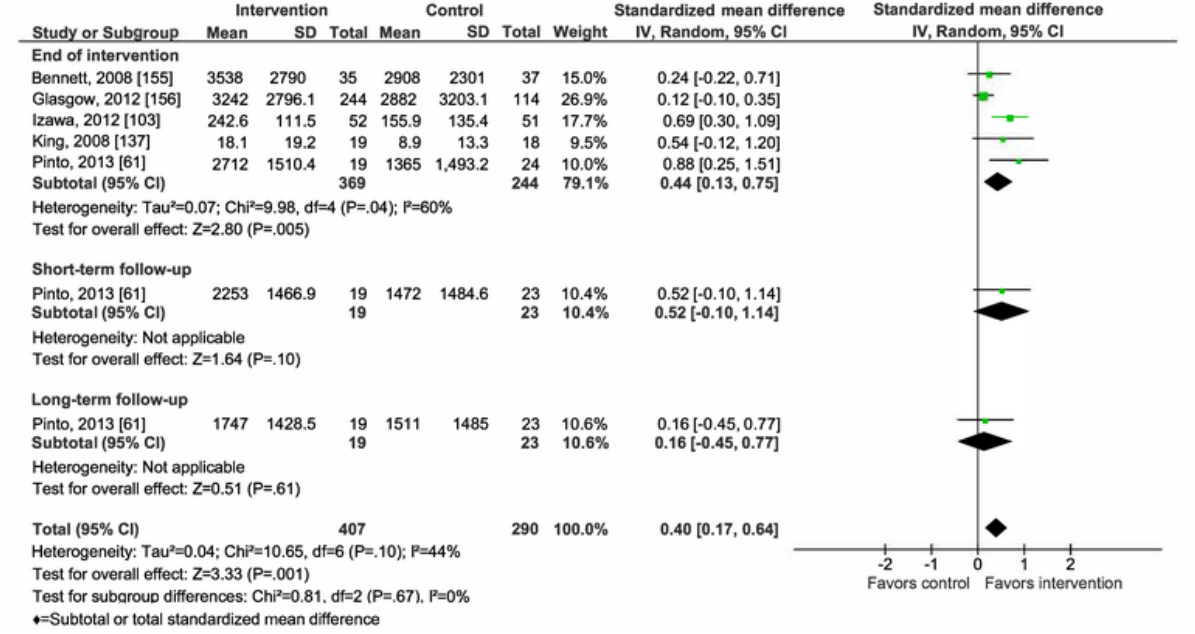
Figure 9. Primary outcome analysis by measurement time point for the outcome energy